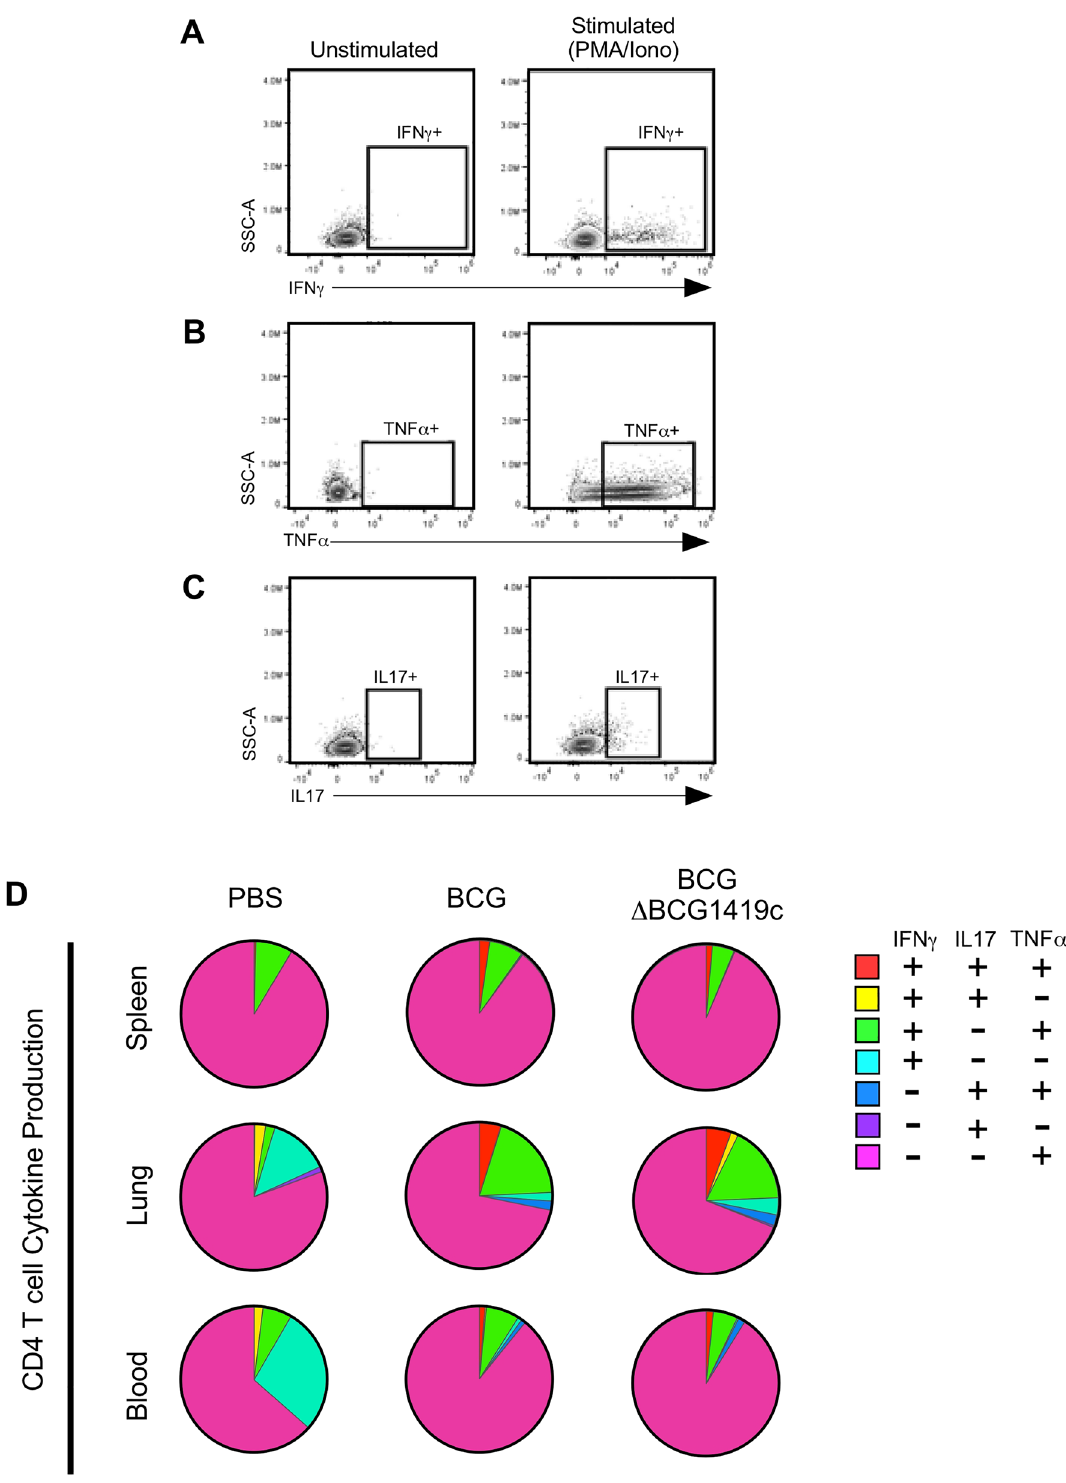
Figure 8. CD4 T cell cytokine production in BCG- and BCGΔBCG1419c-immunized mice. C57BL/6 mice were s.c. immunized with 10 4 CFU of either BCG or BCGΔBCG1419c, or PBS as a control; 18 days later, mononuclear cells from the spleen, lung and blood were prepared and used for intracellular cytokine staining, following stimulation with PMA/Ionomycin. Shown are ( A ) representative IFNγ staining, ( B ) representative TNFα staining and ( C ) representative IL17 staining of unstimulated and stimulated mononuclear cells, gated off CD4 T cells; ( D ) Spice analysis of single positive (IFNγ + , TNFα + , IL17 + ), double positive (IFNγ + IL17 + , IFNγ + TNFα + , IL17 + TNFα + ), and triple positive (IFNγ + , TNFα + , IL17 + ) CD4 T cells in the spleen, lung and